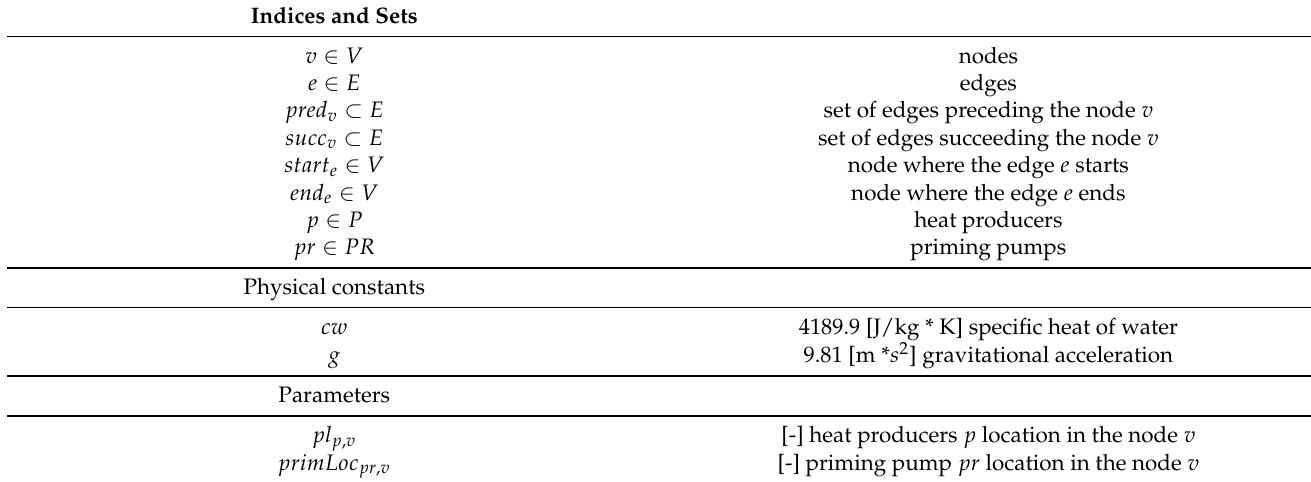
Table A1. List of indices and sets used in the model formulae.